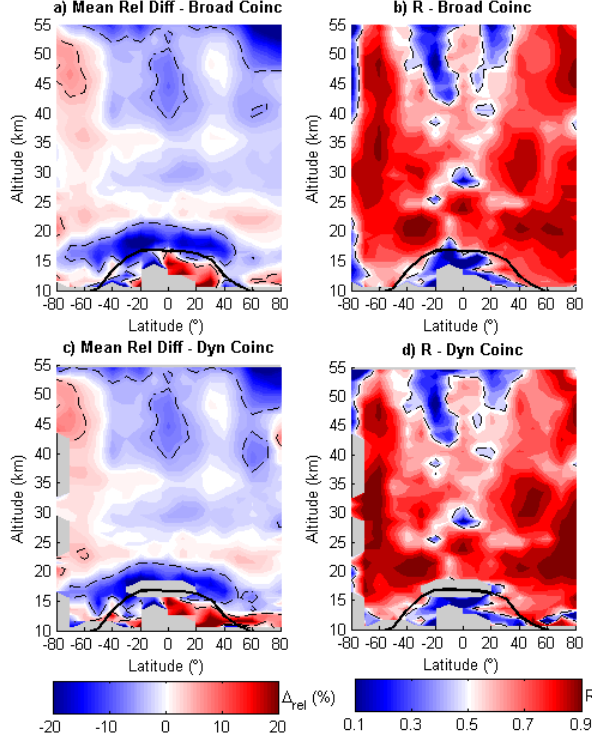
Fig. 6. Latitudinal variation for comparisons between OSIRIS and SAGE II measurements, calculated for 10 ◦ latitude bins (x-axis) at various altitudes (y-axis) for (top) broad coincidence criteria and (bottom) dynamical coincidence criteria (see Table 1). (Left) Contours of mean relative differences (color scale), with the black dashed lines indicating ± 5% mean relative difference. (Right) Contours of the correlation coefficient, R , with the black dashed lines indicating R = 0 . 5. The thick black lines indicate the average World Meteorological Organization thermal tropopause height of the coincident measurements, calculated from European Center for Medium-Range Weather Forecast analysis data. The grey shading indicates regions for which there are fewer than 10